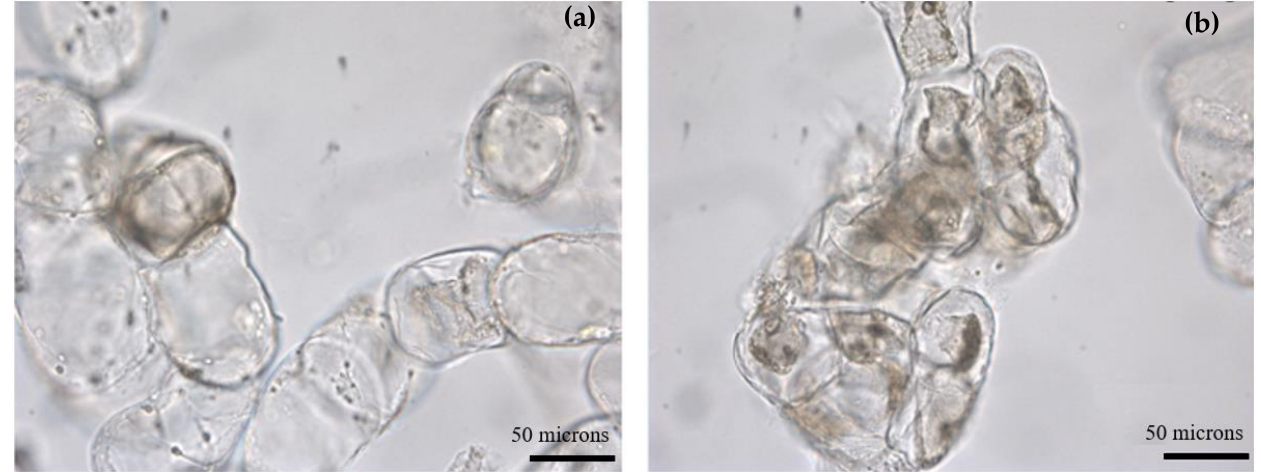
Figure 5. Cell clusters in suspension cultures of T. officinale maintained at ( a ) 1.0% ( w / v ) sucrose, ( b ) 5.5% ( w / v ) sucrose (Basal MS medium, 3.0 mg/L NAA, 3.0 mg/L BAP, 20 ± 2 °C, 115 rpm, 8th week of culture (bar = 50 microns).